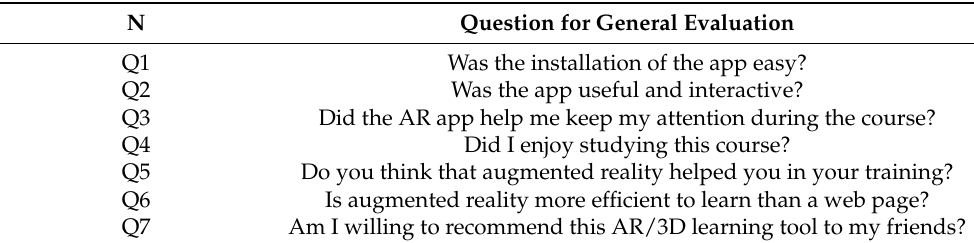
Table 3. General evaluation for the use of the AR-electronics